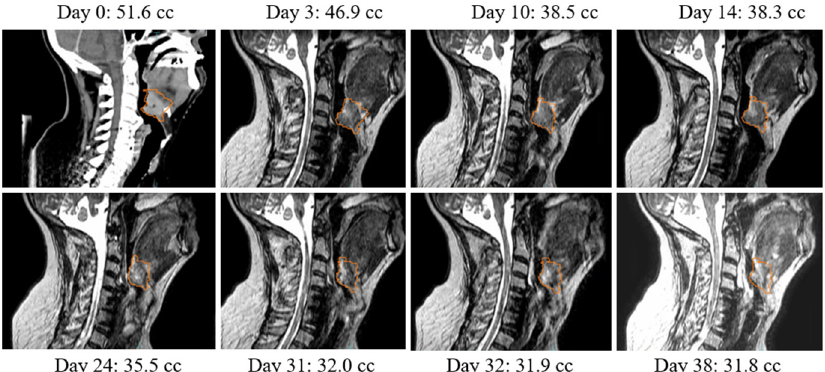
Figure 7. Regression of tumor volume over the course of treatment.